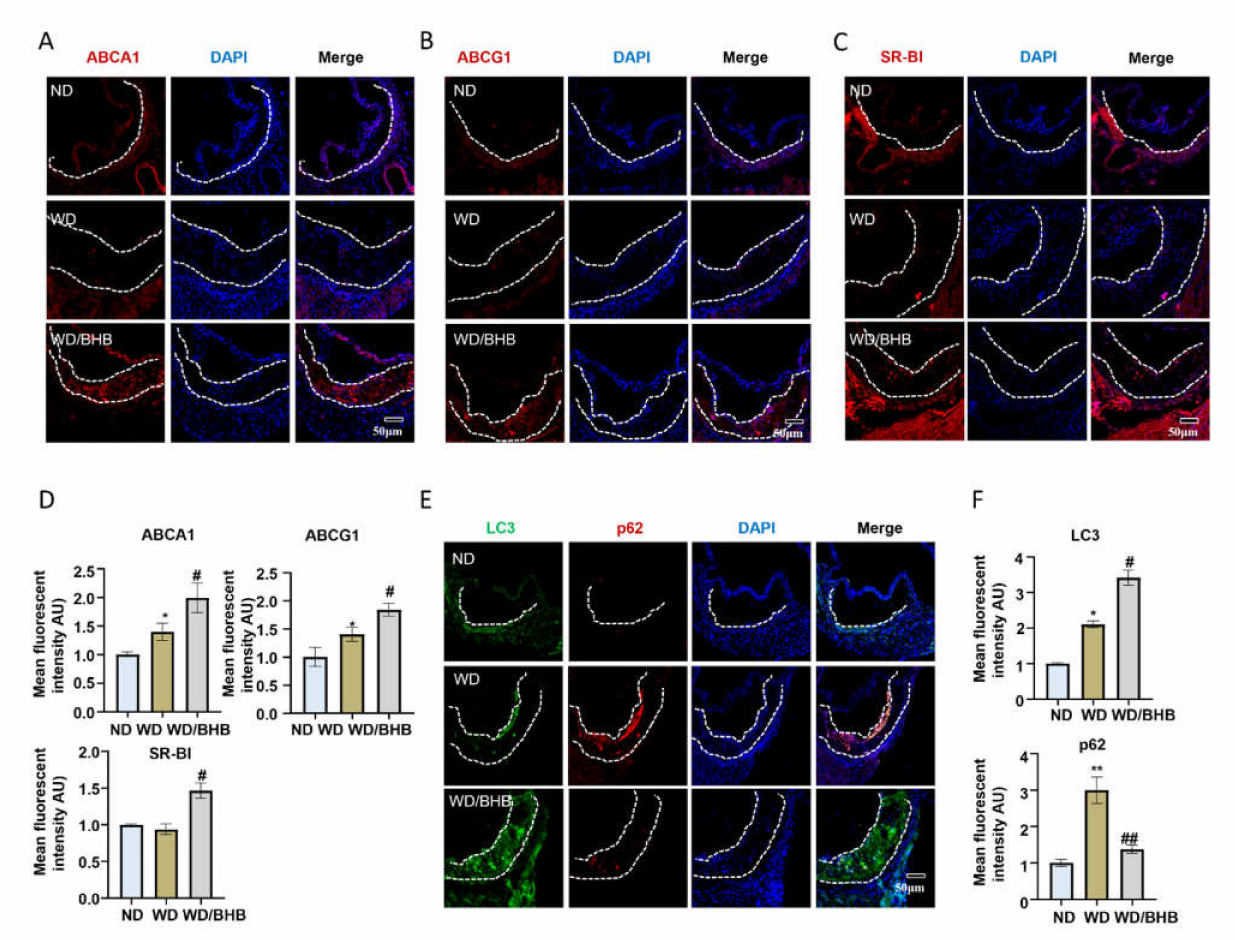
Figure 6. BHB increases the expression of cholestene transporters and induces autophagy. ( A – C , E ) Representative immunofluorescence images of frozen sections of aortic roots from ApoE − / − mice. ( A ) ABCA1 stains (red) and DAPI nuclear stains (blue). Scale bars, 50 µ m. ( B ) ABCG1 stains (red) and DAPI nuclear stains (blue). Scale bars, 50 µ m. ( C ) SR-BI stains (red) and DAPI nuclear stains (blue). Scale bars, 50 µ m. ( E ) LC3 stains (green), p62 stains (red), and DAPI nuclear stains (blue). Scale bars, 50 µ m. ( D , F ) Quantification of immunofluorescence images (n = 6). Data are represented as means ± SEM. * p < 0.05, ** p < 0.01 vs. ND mice; # p < 0.05, ## p < 0.01 vs. WD